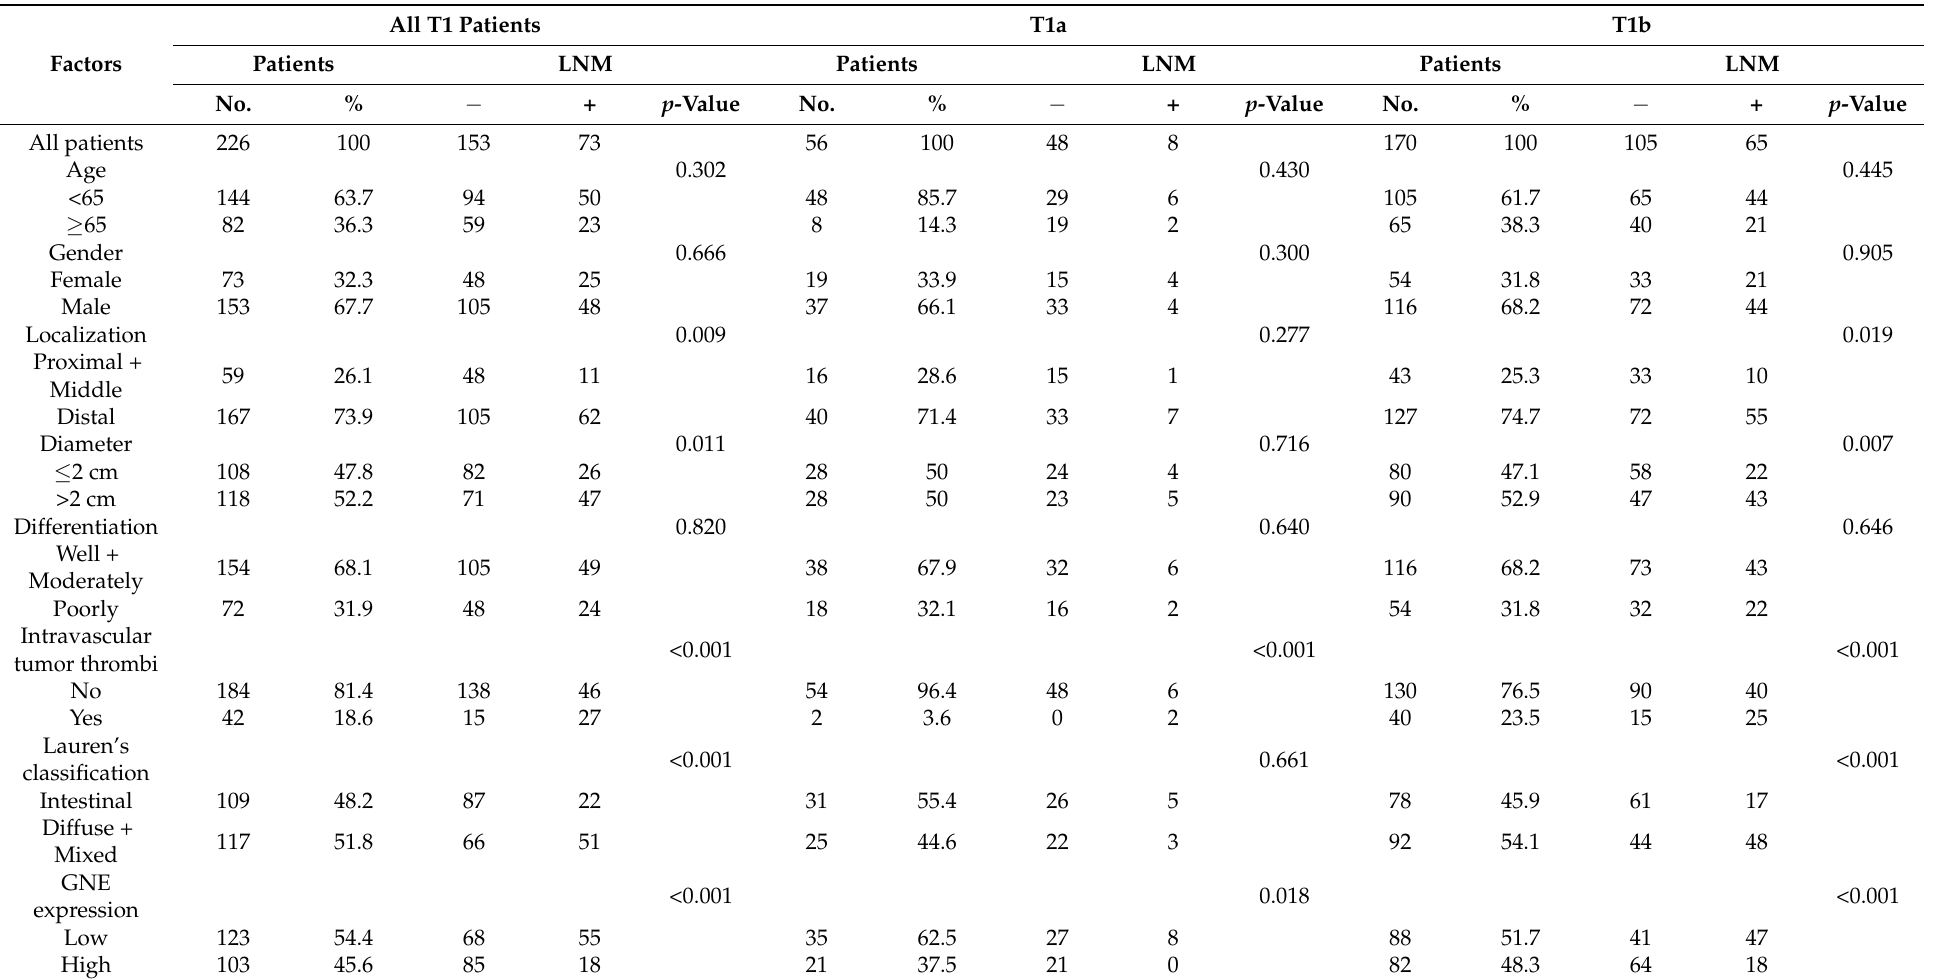
Table 2. Correlation of lymph node metastasis with clinicopathological characteristics in